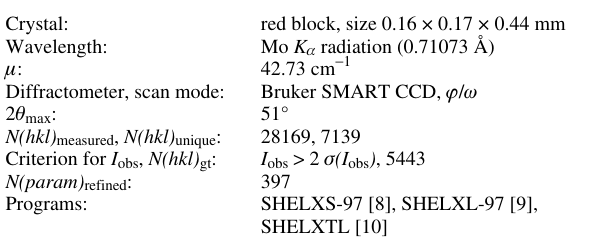
Table 1. Data collection and handling.